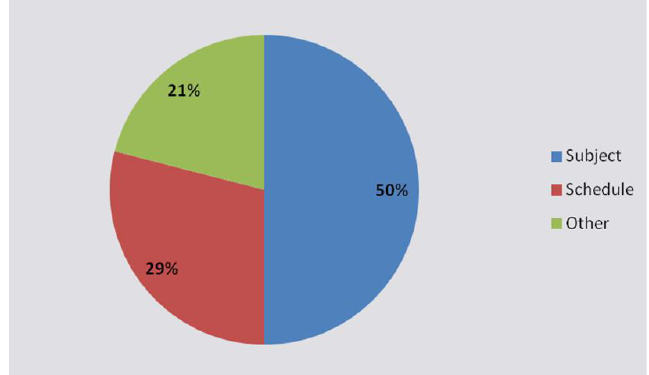
Figure 2. Main reasons for choosing this project, according to the students